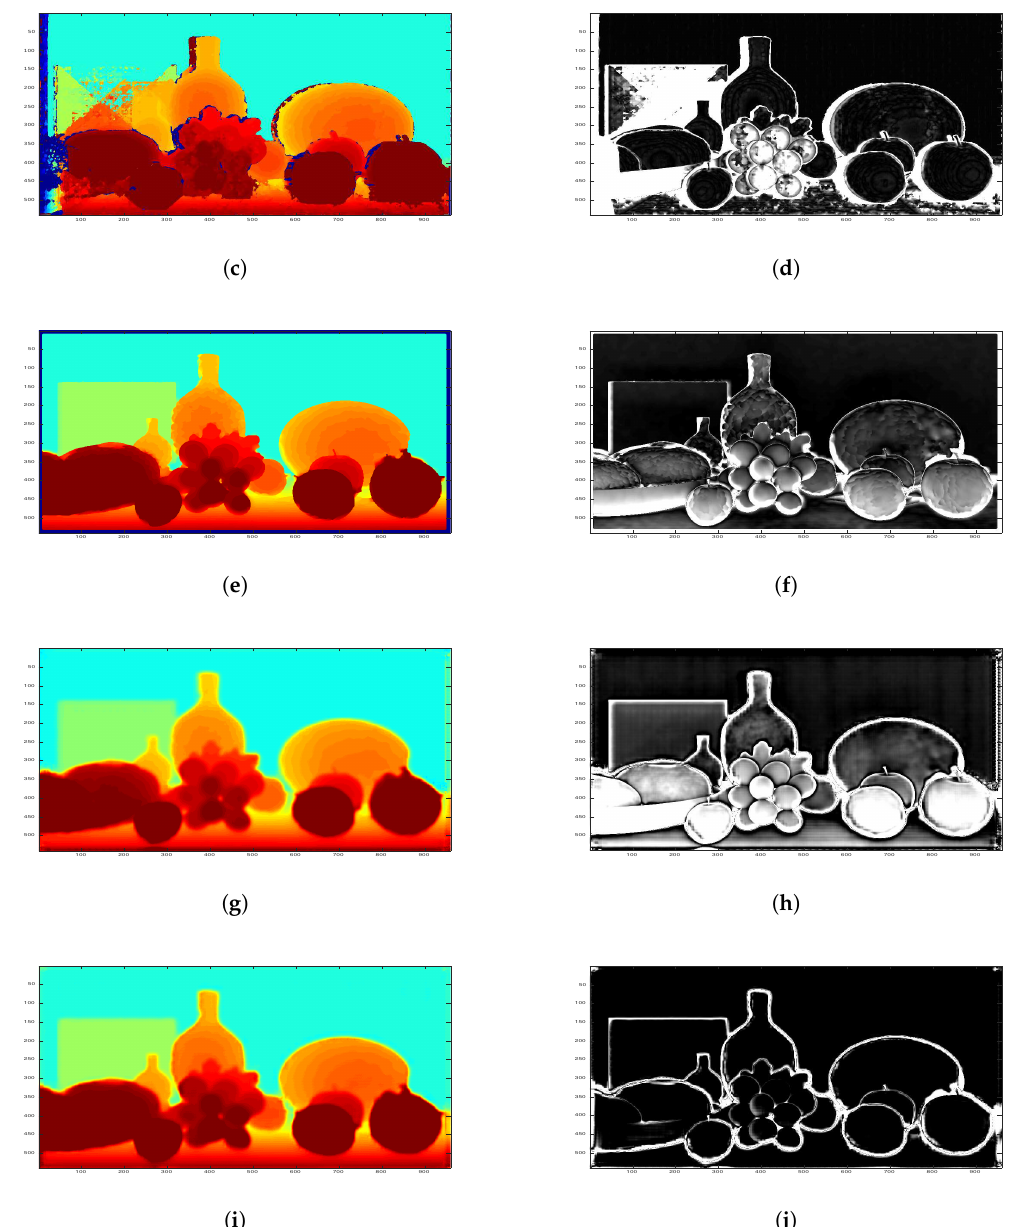
Figure 6. One qualitative result for ToF-stereo fusion with many invalid pixels input. The inputs are from ToF and disparity calculation algorithm using SGM in OpenCV. The lighter pixels in ( d , f , h , j ) represent larger disparity error. ( a ) Ground Truth; ( b ) Color image; ( c ) ToF; ( d ) ToF error; ( e ) SGM OpenCV; ( f ) SGM error; ( g ) Supervised 1; ( h ) Supervised error; ( i ) Semi 2; ( j ) Semi 2